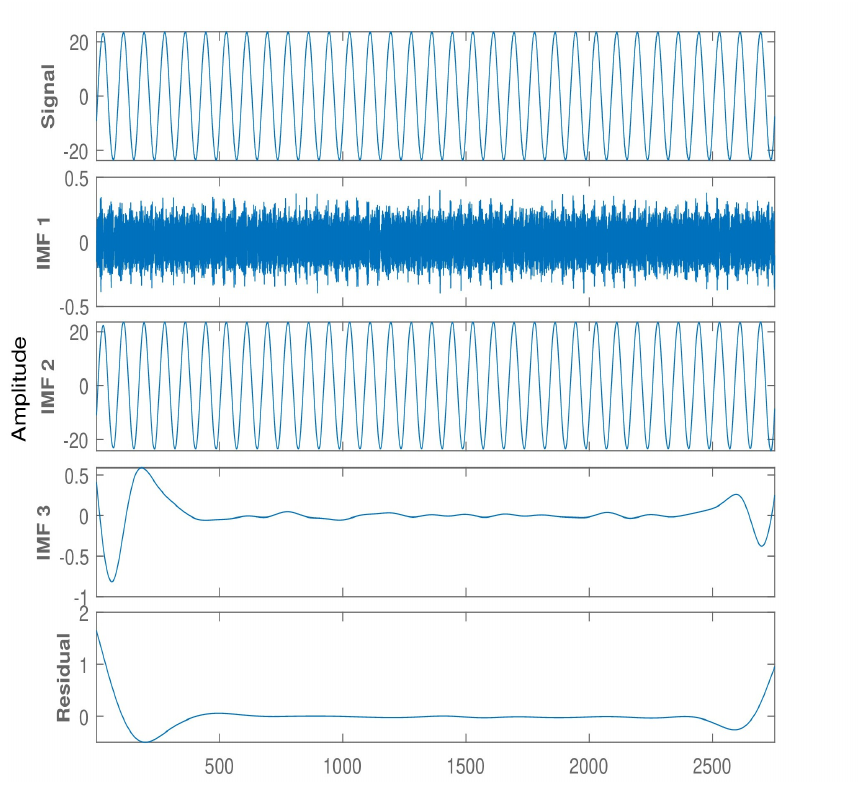
Figure 4. Empirical mode decomposition at healthy condition.